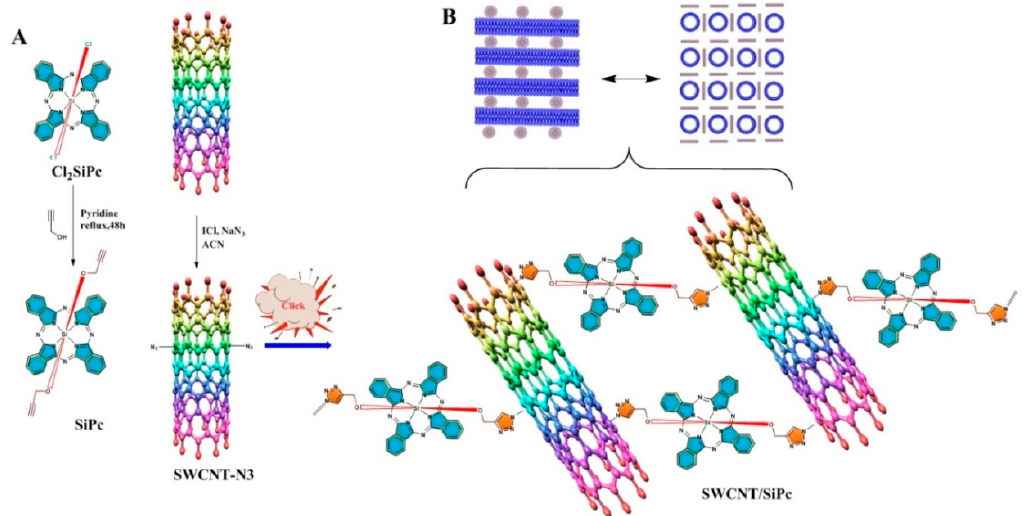
Figure 1. ( A ) Synthetic pathway of axially terminal propynoxy substituted silicon (IV) phthalocyanine and its hybrid nanomaterial with SWCNT; ( B ) Schematic illustration of the SWCNT/SiPc hybrid material.